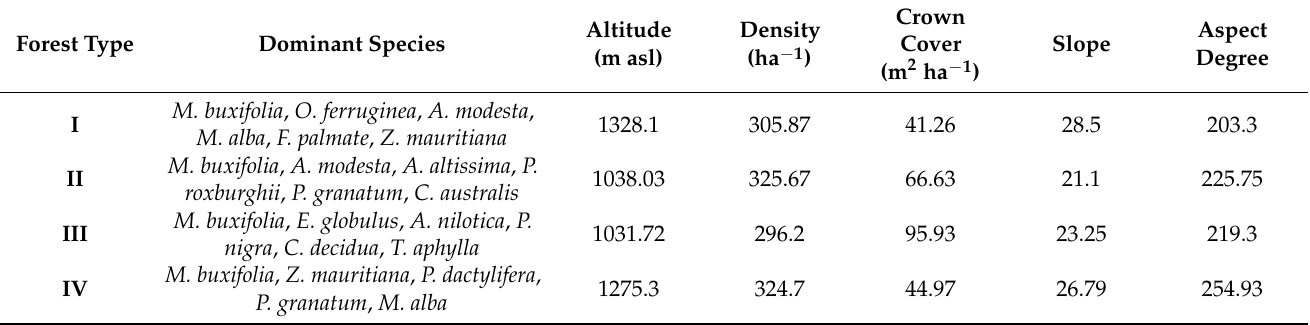
Tree Types, Life form and Leaf spectra